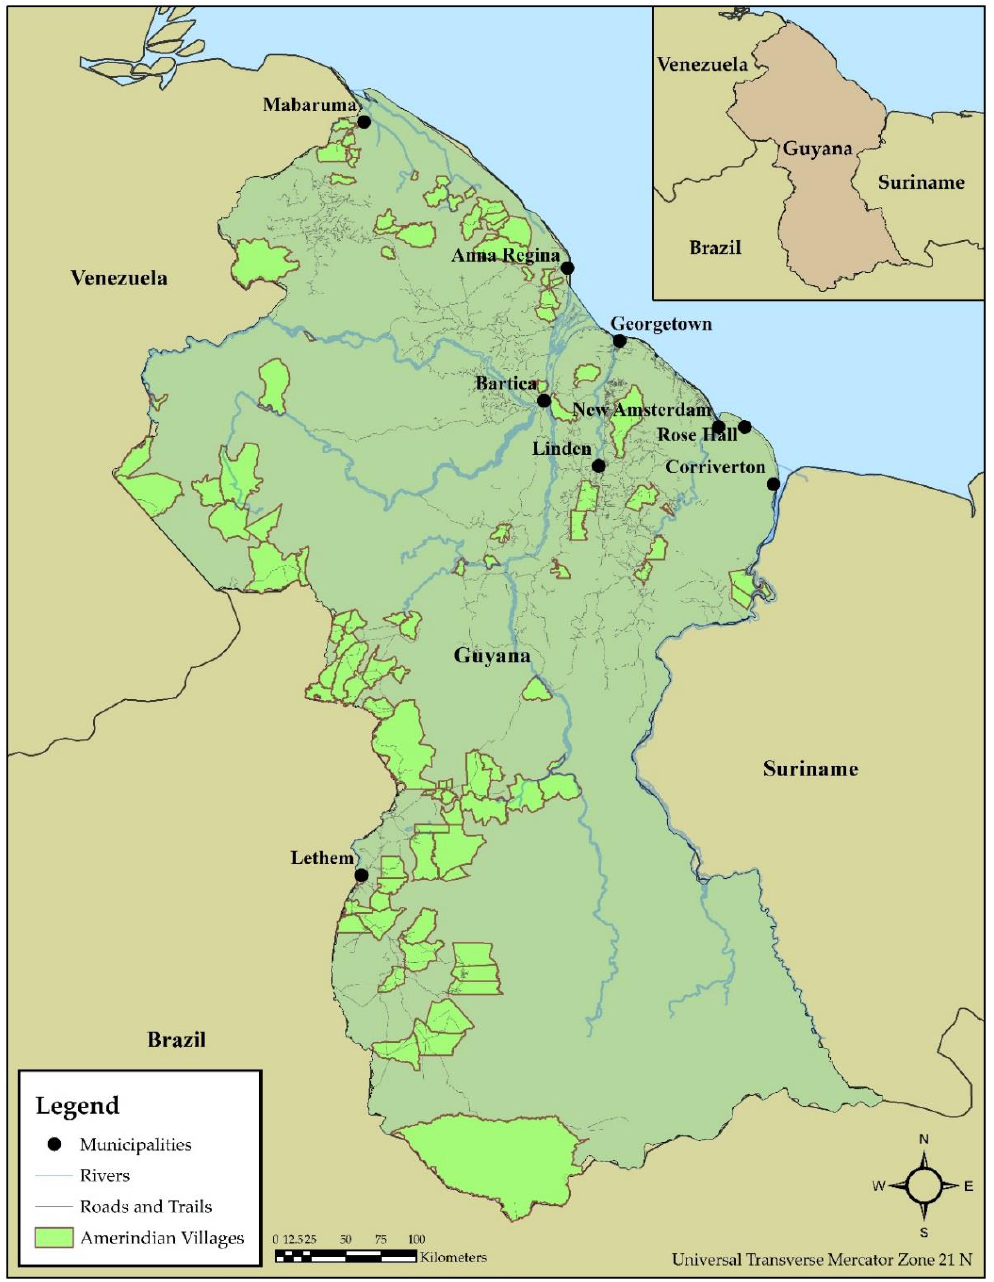
Figure 1. Study area with the distribution of Amerindian villages across the landscape depicted.